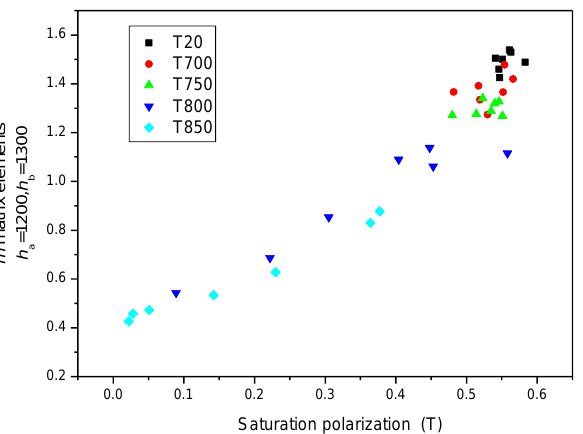
Figure 13. ( h a = 1200 and h b = 1300) m matrix elements for all samples, indicating the actual heat treatments as functions of the saturation polarization.